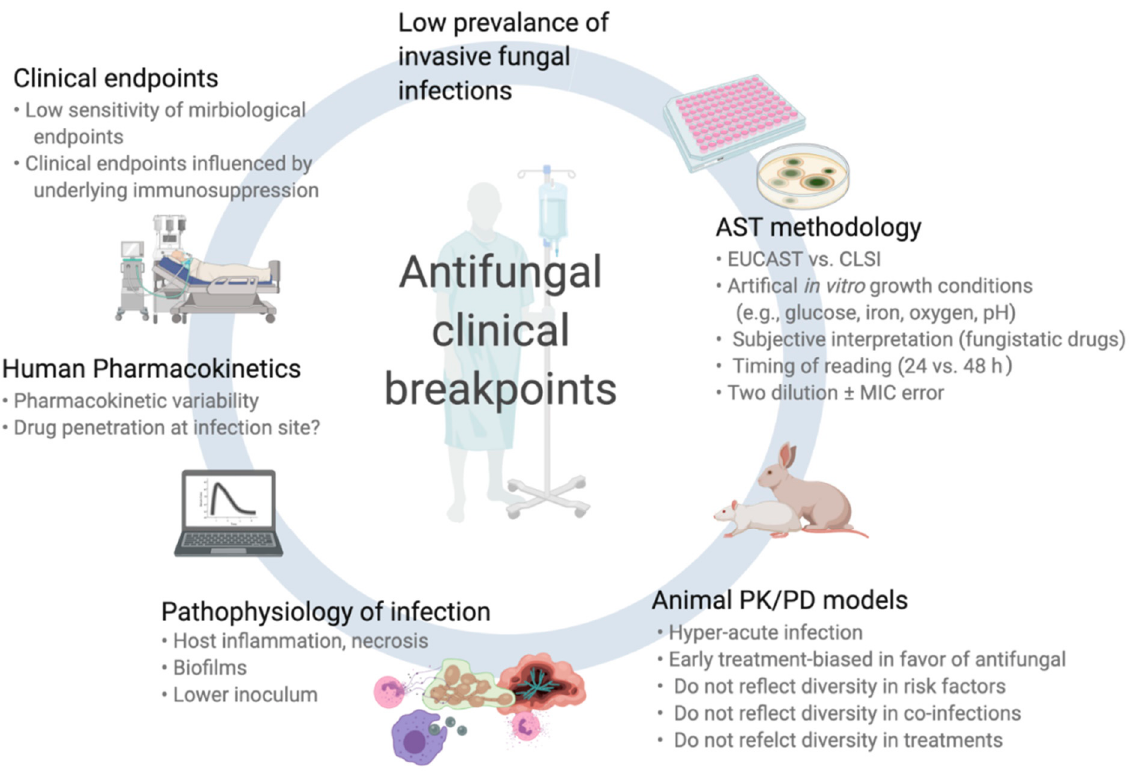
Figure 1. Challenges and pitfalls in the assessment of clinical breakpoints for fungi and antifungal drugs.